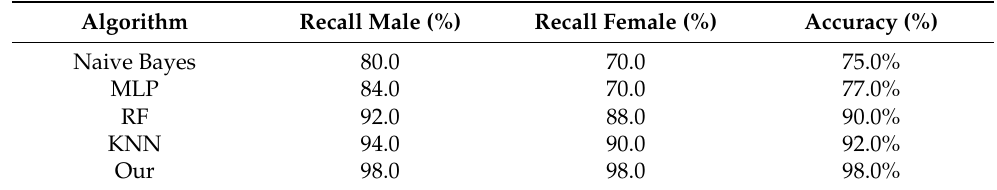
Table 8. Comparison of the proposed system with the conventional systems based on classification ac- curacy.